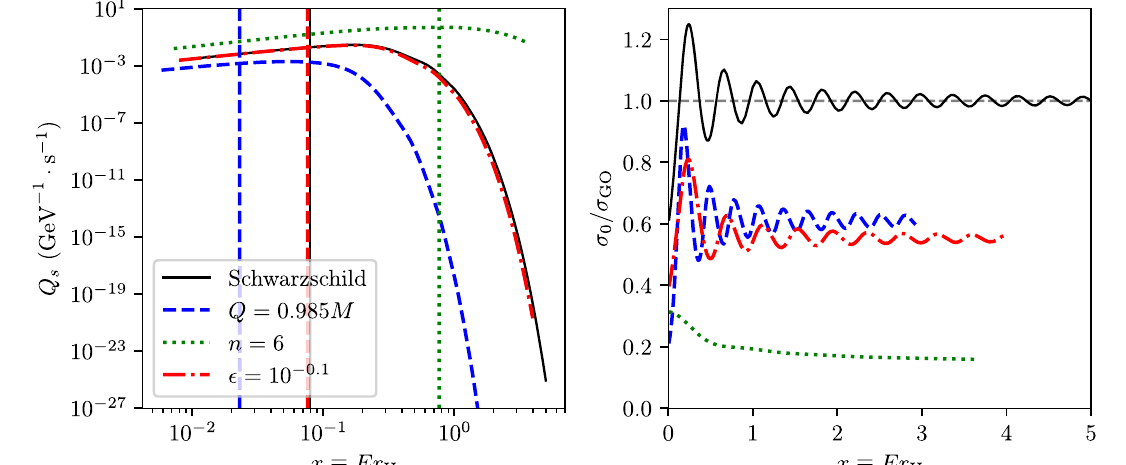
x ≡ Er H where r H is the BH exterior horizon in the corresponding met- ric. Left: The full Hawking radiation spectra. The vertical lines denote the BH temperatures, with the same color and style correspondence as the curves. Right: The high energy cross section oscillations. The grey horizontal dashed line denotes the geometrical optics